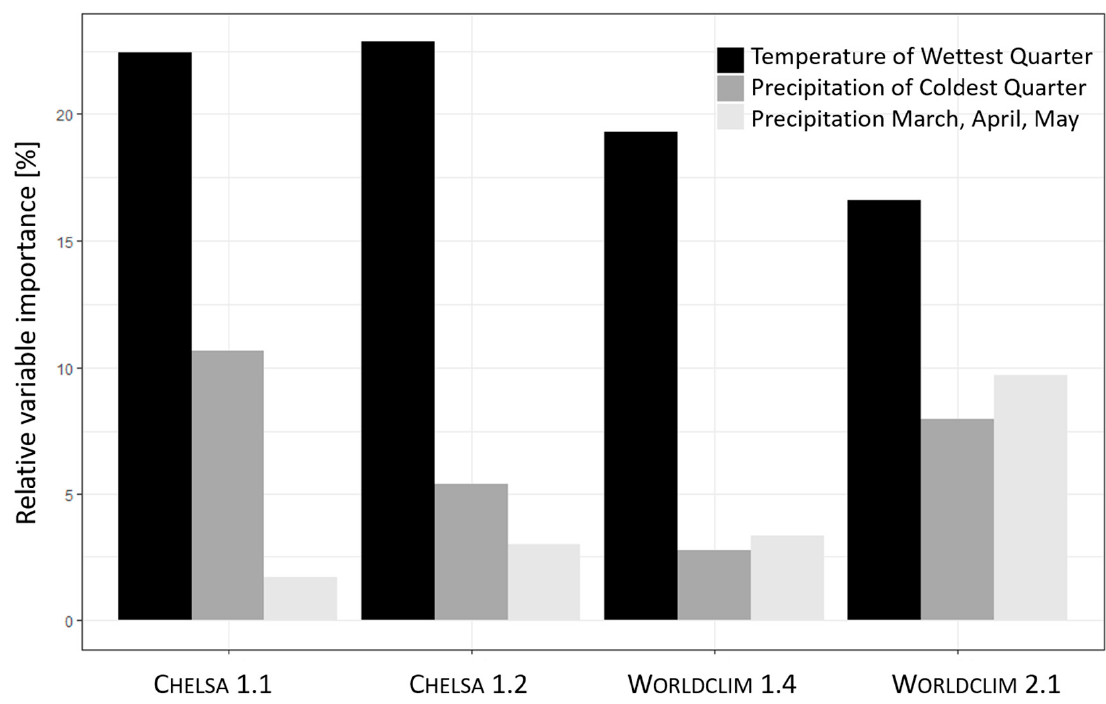
Figure 6. Comparison of variable importance between final models for Betula utilis between climate datasets and respec- tive